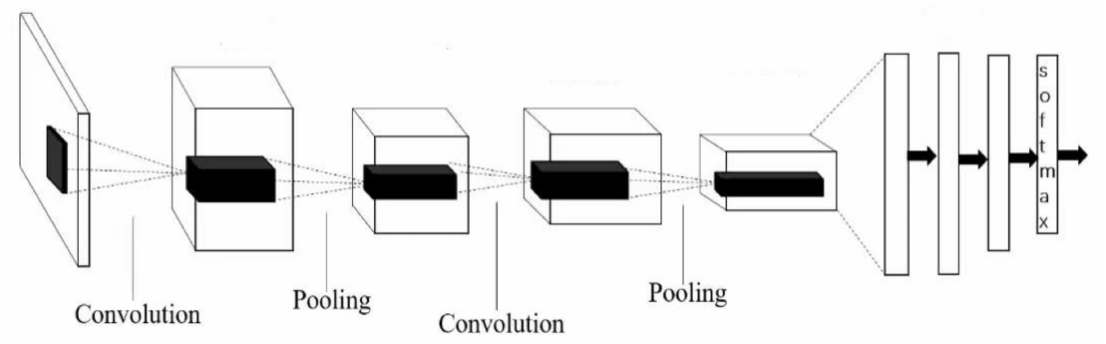
Figure 2. Schematic diagram of convolutional neural network structure.